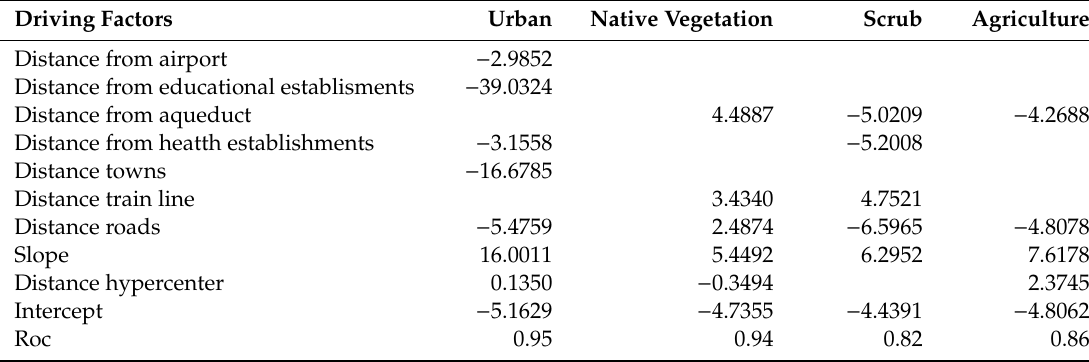
Table 5. Logistic regression results (coe ffi cients) for each type of land use to be modeled. The value of the receiver operating characteristics (ROC) curve is included in the final line as a model